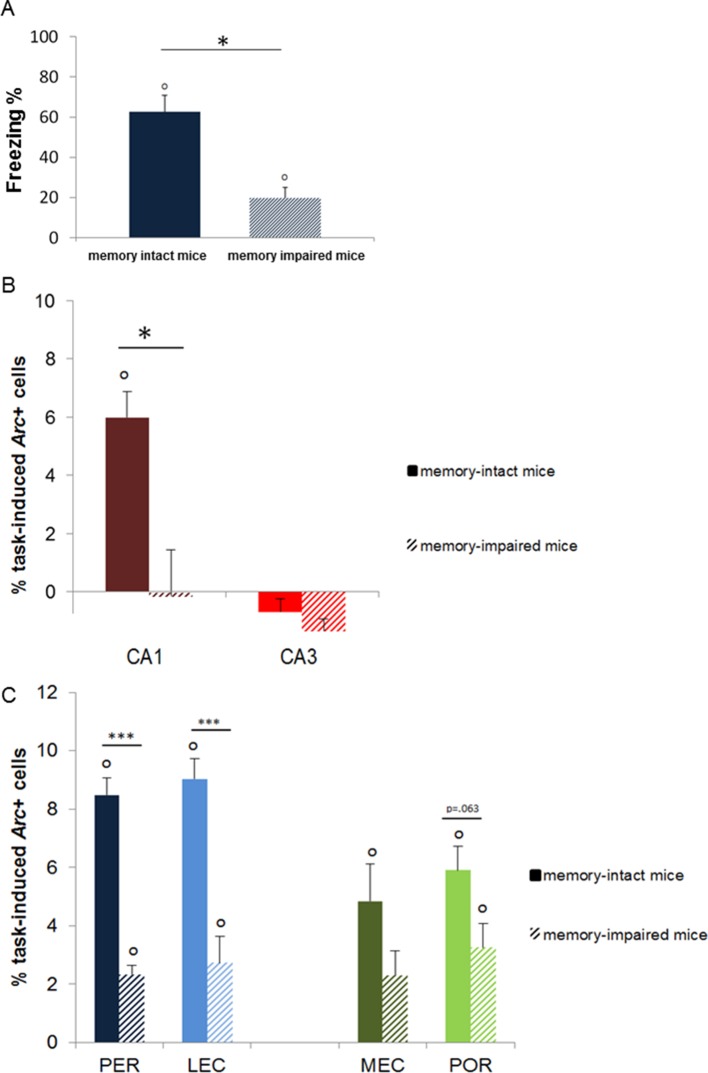
Memory performance of ‘memory-intact’ and ‘memory- impaired’ mice tested one year after conditioning and corresponding MTL patterns of activity.(A) Behavioral performance: ‘memory-impaired’ mice froze significantly less than ‘memory-intact’ mice at test, reflecting impaired memory retrieval in this group. (B) Activity patterns in CA1 and CA3: in contrast to mice that successfully retrieved the footshock-context association one year after conditioning, CA1 was not recruited in those that had impaired memory. In addition, activity levels in CA3 were comparable between the two groups, underlining the critical role of CA1 in the retrieval of very remote memories. (C) Activity patterns in parahippocampal areas: parahippocampal areas of the ‘memory-impaired’ mice were recruited to much lesser extent than those of ‘memory-intact’ animals. Since this reduced activation did not lead to successful memory retrieval, this result suggests that CA1 might play a role as important as the cortical areas in the retrieval of very remote memories in memory-intact mice. Error bars are mean ± SEM. ‘o’ indicate a significant comparison to 0 at p<0.05; asterisks a t-test at p<0.05 for ‘*’ and at p<0.01 for ‘***’.